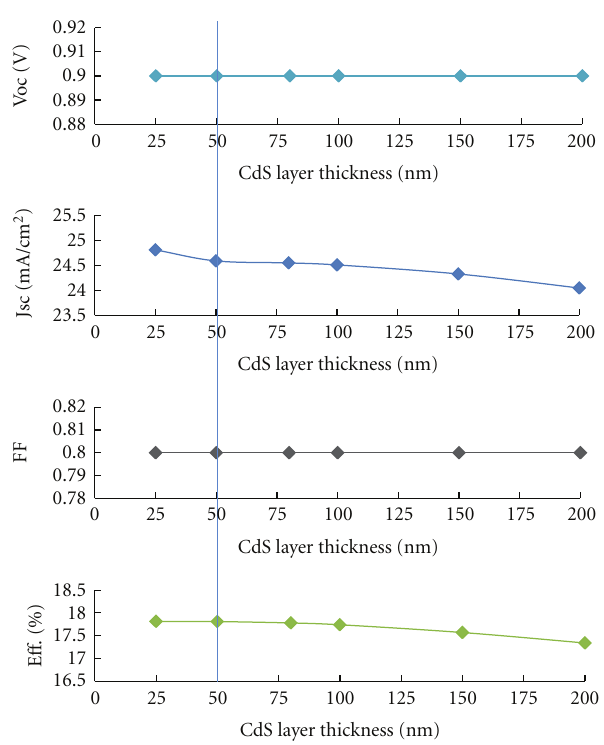
Figure 4: E ff ect of CdS window layer thickness on cell parameters.